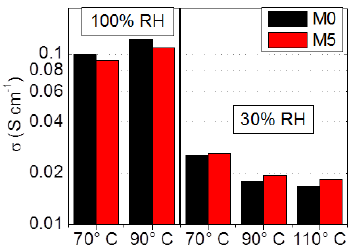
Figure 8. Conductivity of the membranes at different temperature ( x -axis) and different RH .